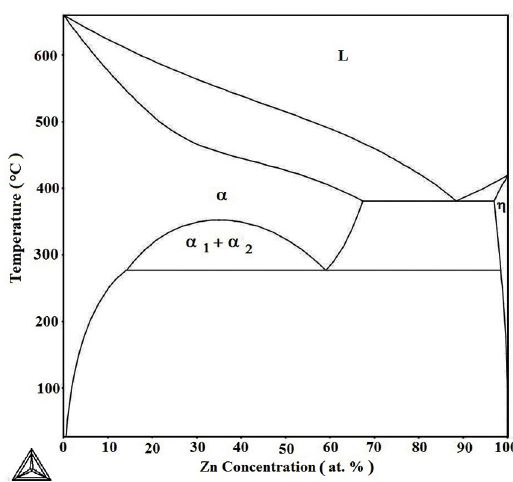
Figure 1. Calculated equilibrium Al-Zn phase diagram.